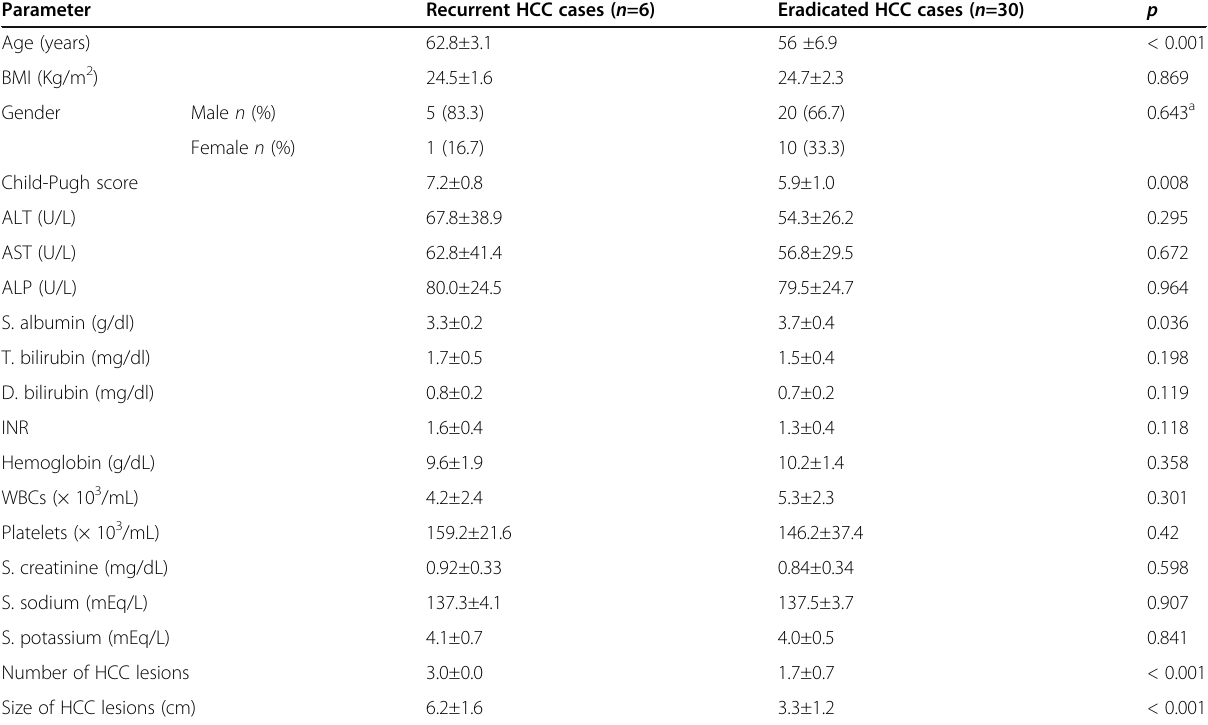
Table 6 Demographic, clinical and biochemical parameters among recurrent and eradicated HCC